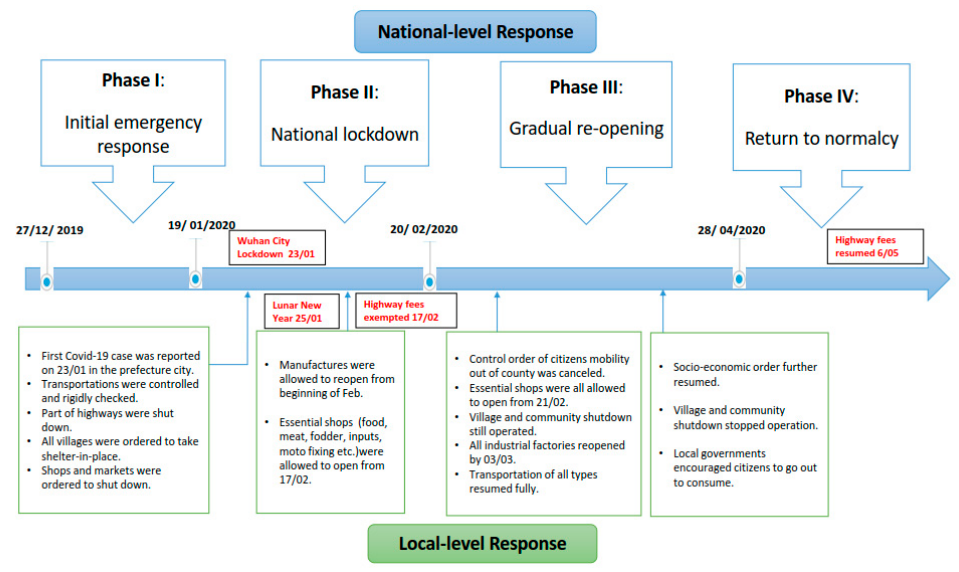
Figure 1. National and local responses to the COVID-19 pandemic.